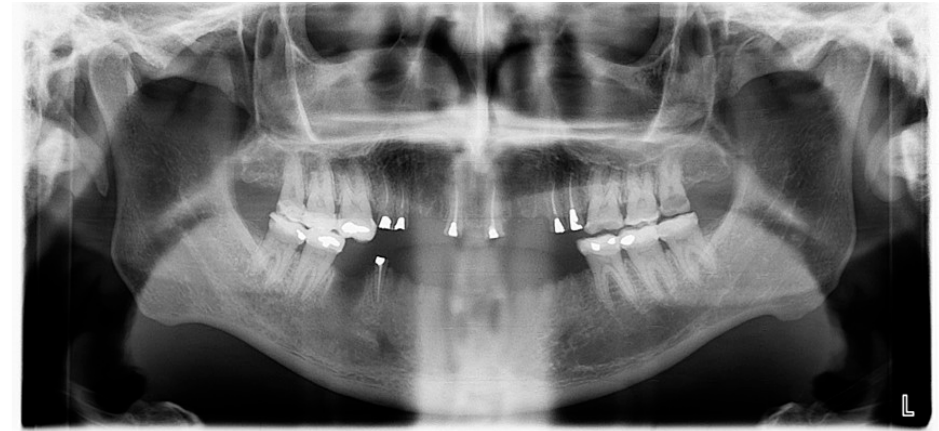
Figure 6. Panoramic radiograph after procedures performed under general anesthesia.